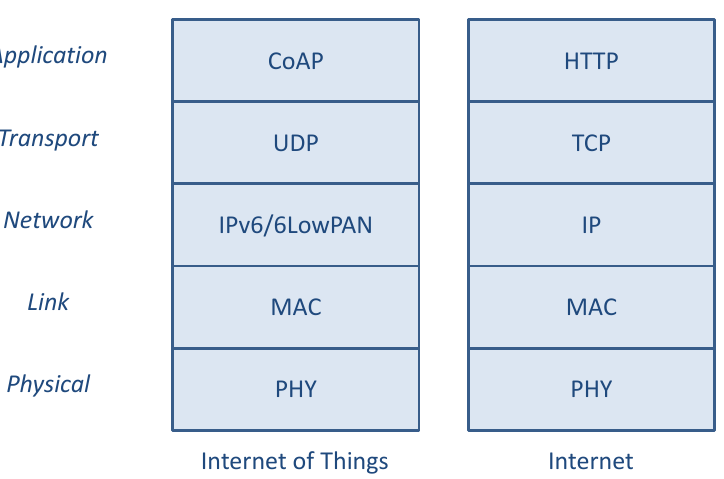
Figure 1. Comparison between the IoT and the Internet protocol stack for OSI